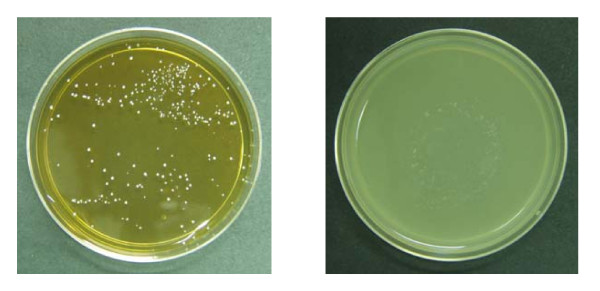
Growth of Candida albicans in culture plate.